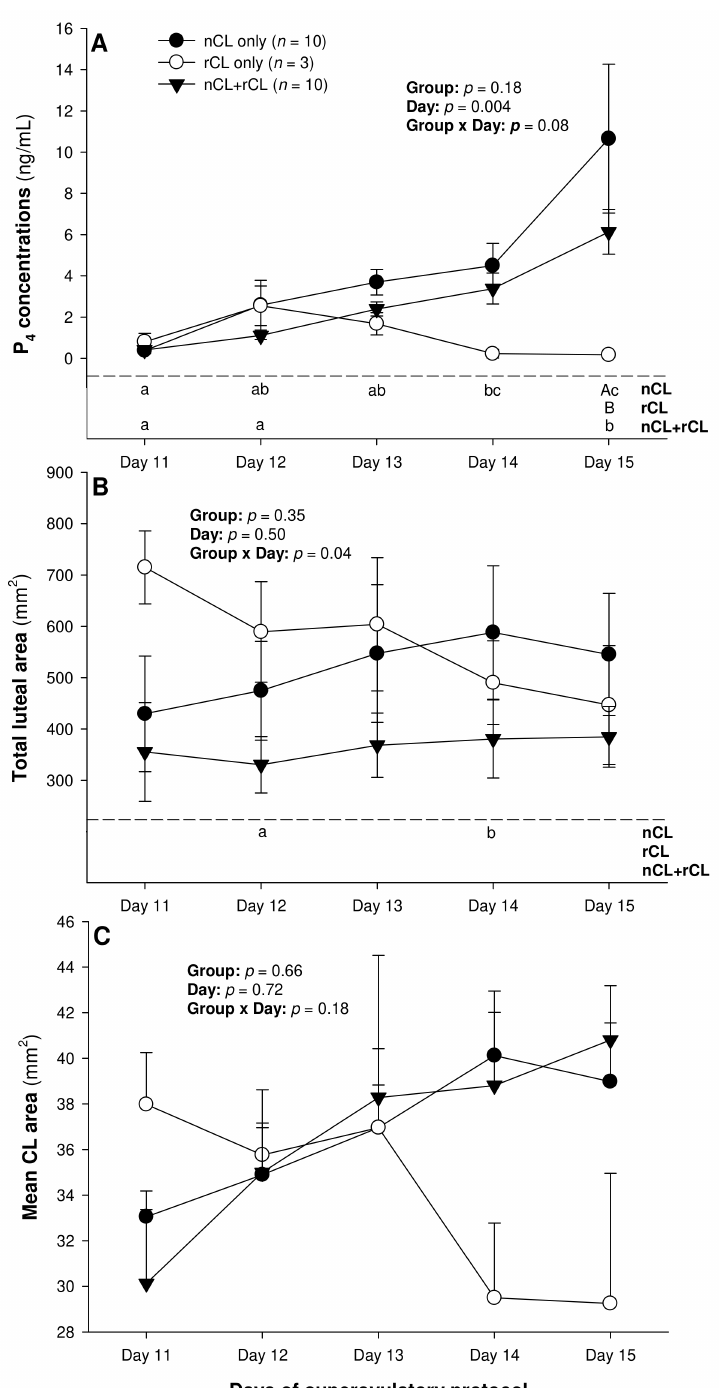
Figure 4. Mean ( ± SEM) serum progesterone (P 4 ) concentrations ( A ), as well as total luteal ( B ), and mean luteal area ( C ) from Day 11 (1 or 2 days after ovulation or beginning of luteogenesis) to Day 15 (day of embryo recovery) of the superovulatory protocol in Santa In ê s ewes that had normal CL (nCL) only, regressing CL (rCL) only or both nCL and rCL following the superovulatory pFSH treatment. Different letters in the lower chart area indicate statistically significant differences: a–c over time within the treatment groups; AB—between the